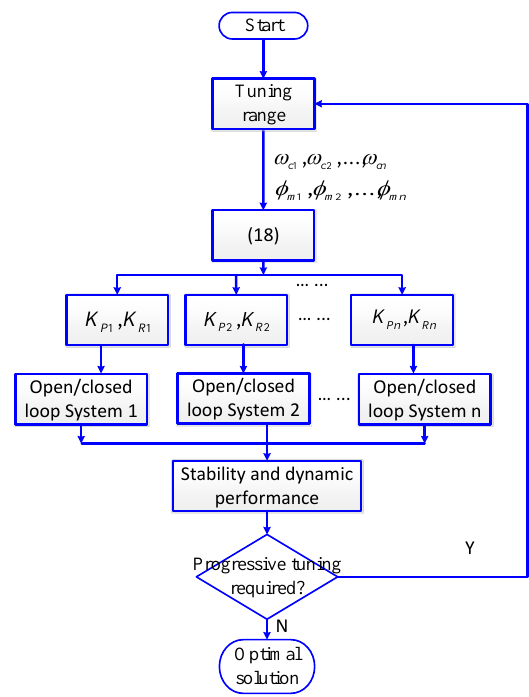
Figure 4. Executing flow chart of the proposed tuning procedure.